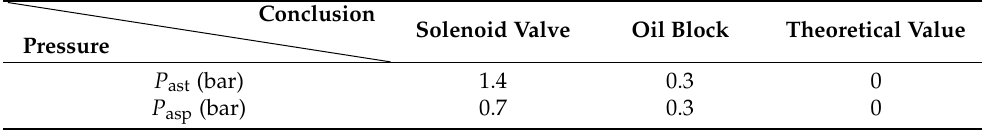
Table 3. Minimal pilot control pressure P ast .